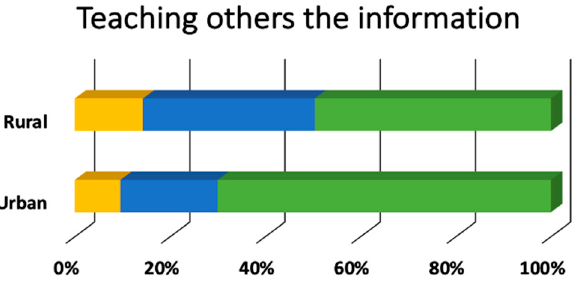
Figure 2. Preference for learning by teaching others significantly differed by school locale. [ n = 361 (rural, n = 131; urban, n = 230), χ 2(2) = 15.1, p < 0.001, Cramer’s V = 0.20].